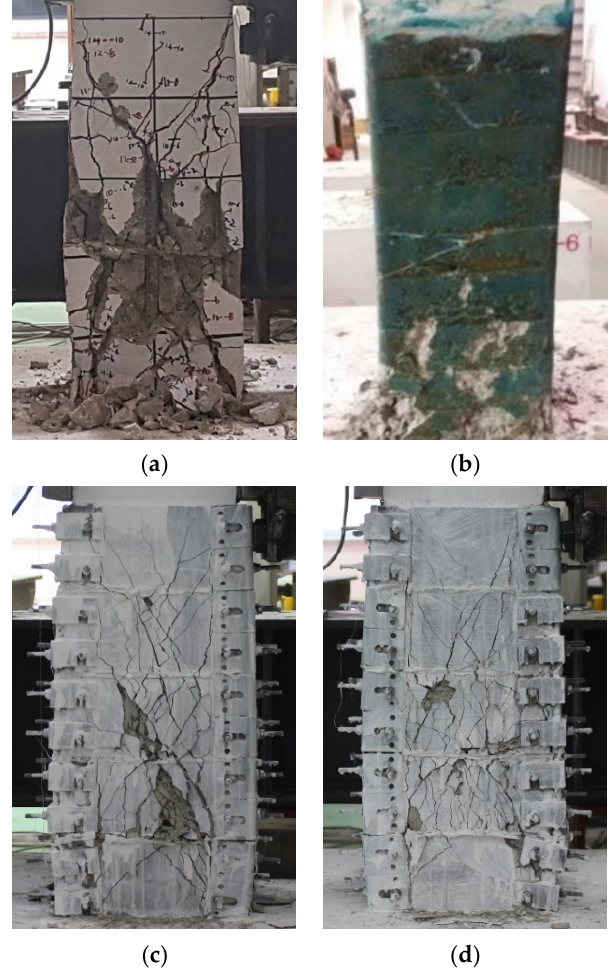
Figure 9. Crack patterns: ( a ) NRF; ( b ) ARF; ( c ) 3DRF4; ( d ) 3DRF6.